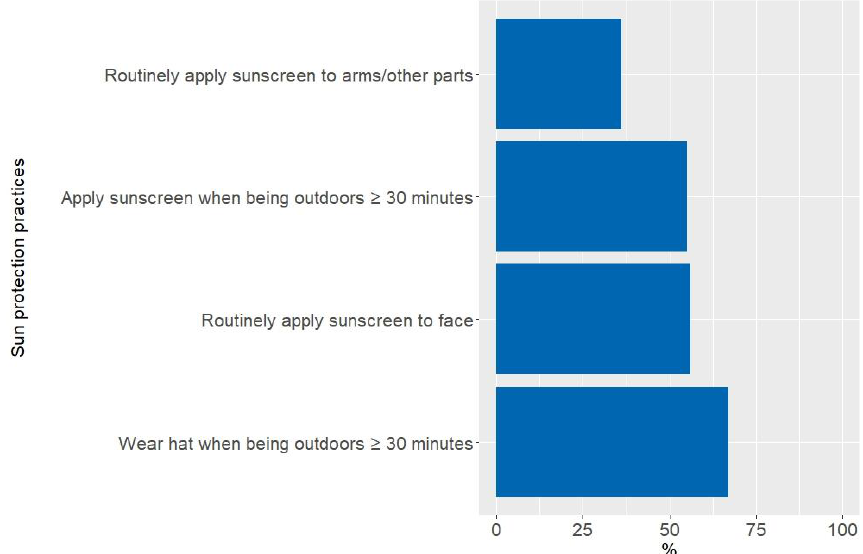
Figure 2. Proportion of sun protection practices reported by the participants. Over-estimating the time outdoors needed to maintain vitamin D in summer was negatively associated with wearing a hat (adjusted PR, APR = 0.86, 95% CI = 0.82–0.89) and applying sunscreen when outdoors for ≥ 30 min (APR = 0.85, 95% CI = 0.81–0.89). Similarly, participants who over-estimated the time required in winter were less likely to apply sunscreen when outdoors for ≥ 30 min (APR = 0.81, 95% CI = 0.76–0.87) (Table 4). Overall, 14% of respondents ( N = 686) reported that they had changed their sun exposure behavior in order to maintain adequate vitamin D status. Of those, 72% spent more time outdoors, 17% applied sunscreen less and 6% sunbathed more often. Women were more likely to report changing their behaviors than men (16% vs. 10%,